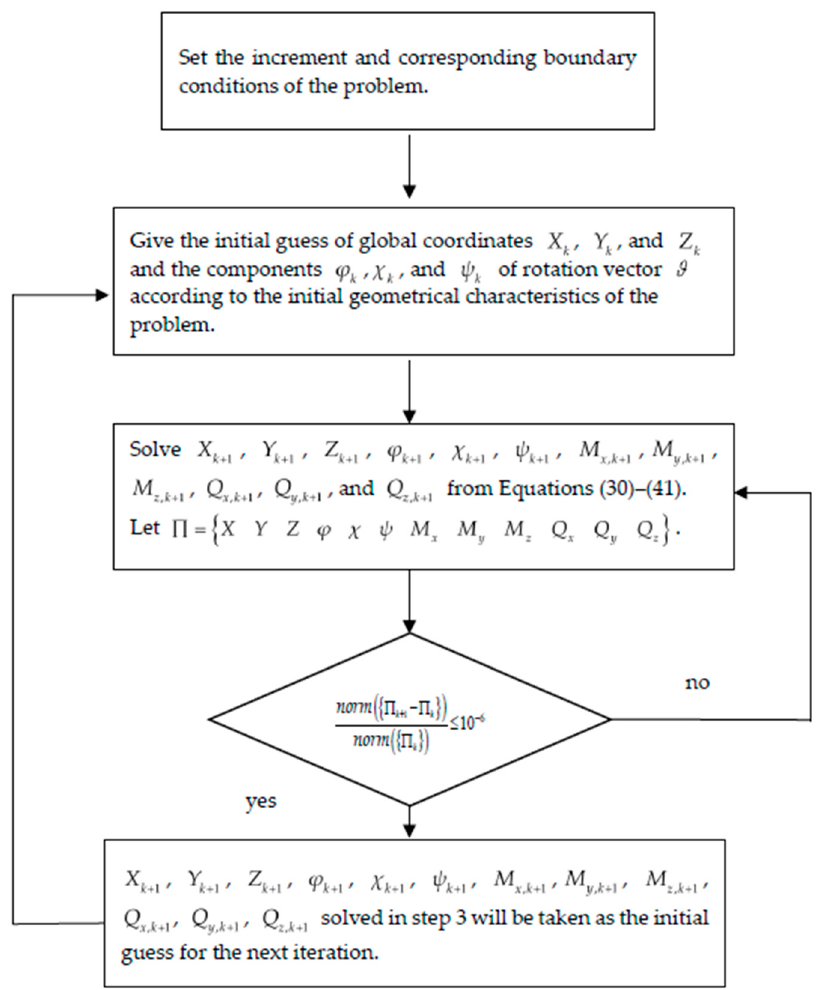
Figure 3. The incremental–iterative steps adopted in the present scheme.